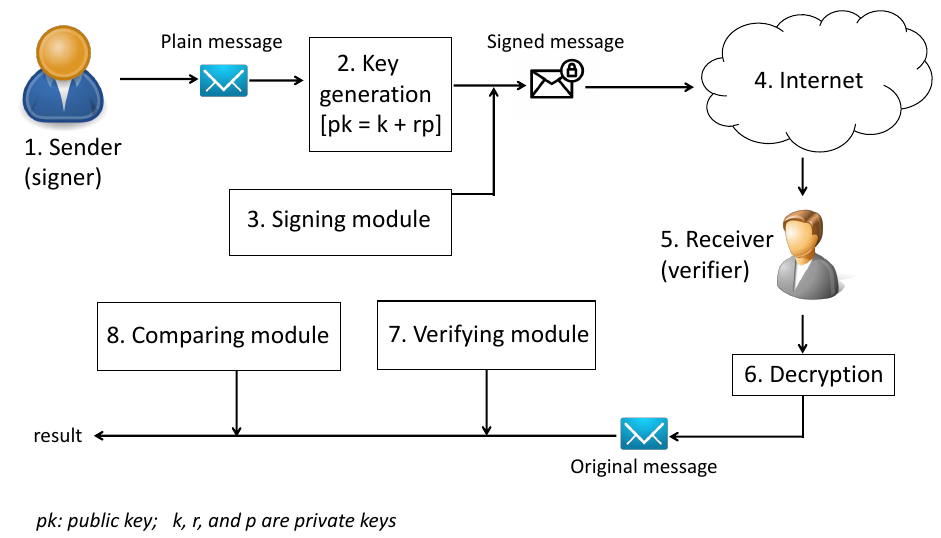
Figure 1. The proposed architectural